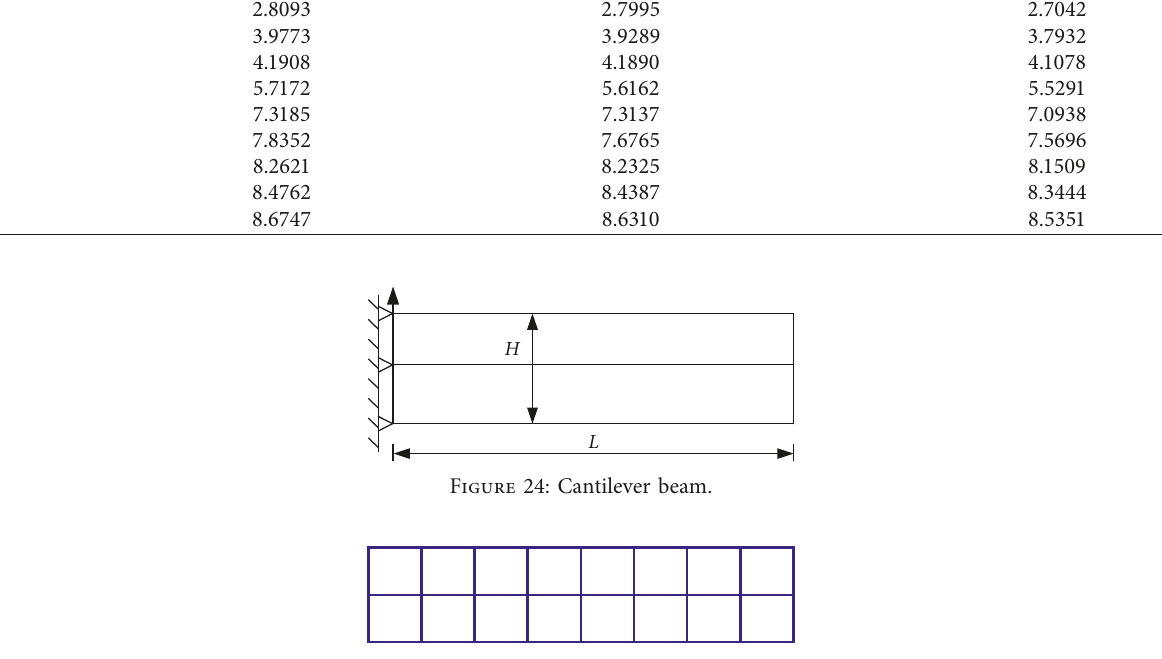
Figure 25: Domain discretization of cantilever beam.